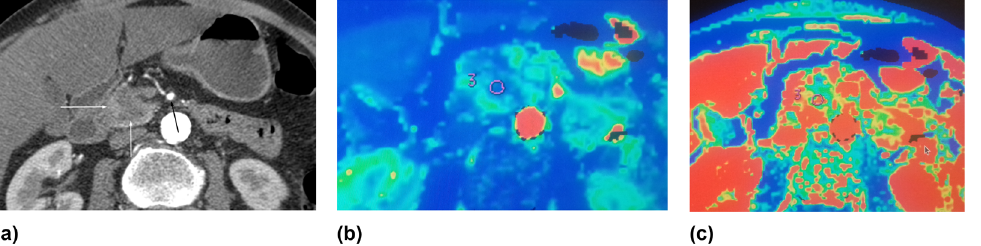
Figure 2: ( a – c ) Poorly di ff erentiated ( G3 ) PDAC in the head of the pancreas. Hypodense tumor in the head of the pancreas: ( a ) contrast - enhanced CT image, axial plane, arterial phase; hypodense mass in the head of the pancreas is seen ( white arrows ) ; no spread to the peripancreatic fatty tissue is detected; no contact with the superior mesenteric artery ( SMA ) ( black arrow ) ; a radiologically resectable tumor; ( b and c ) perfusion CT images of the same patient; third ROI of 4 is shown; ( b ) signi fi cantly reduced BF ( 29.24 mL min − 1 100 g − 1 ) in the tumor was detected; ( c ) reduced blood volume of the tumor – 6.13 mL 100 g − 1 ( ROI ) . The examination of the surgical specimens revealed poorly di ff erentiated PDAC ( G3 )